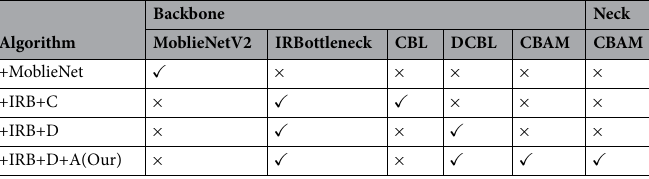
Table 1. Ablation